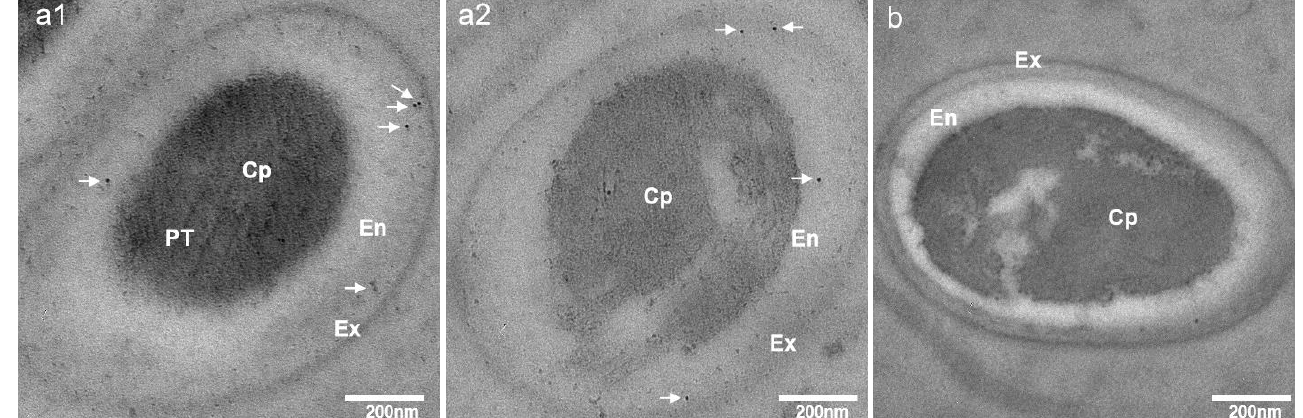
Figure 8. Immunofluorescence localization of EhSWP3 on the spore wall of purified Enterocytozoon hepatopenaei spores. Panel ( a – d ) normal rabbit serum. Panel ( e – h ): rabbit anti- EhSWP3 serum. ( d ) merged images of ( b , c , h ) merged images of ( f , g ). The blue fluorescence signal represents the nuclei of the spores.